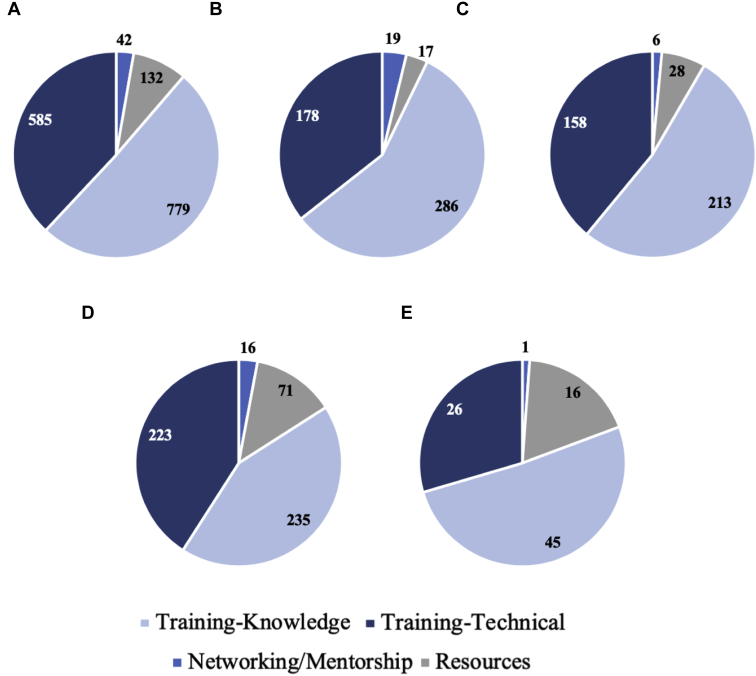
Categorization of respondent requests into categories of knowledge-based training, technical training, networking/mentorship, and resources. (A) Overall respondents and (B–E) by World Bank income classification: (B) high-income countries, (C) upper middle-income countries, (D) low-middle-income countries, and (E) low-income countries.